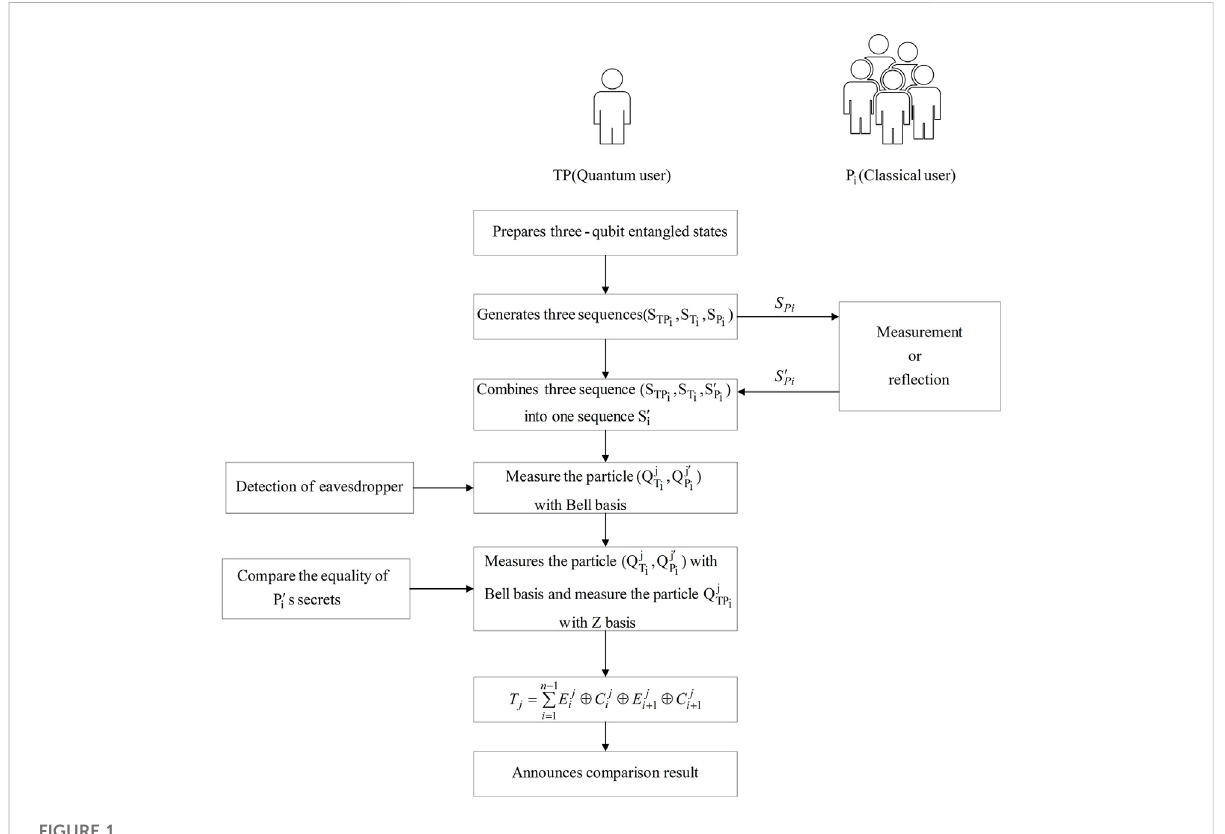
FIGURE 1 Process of the proposed SQPC